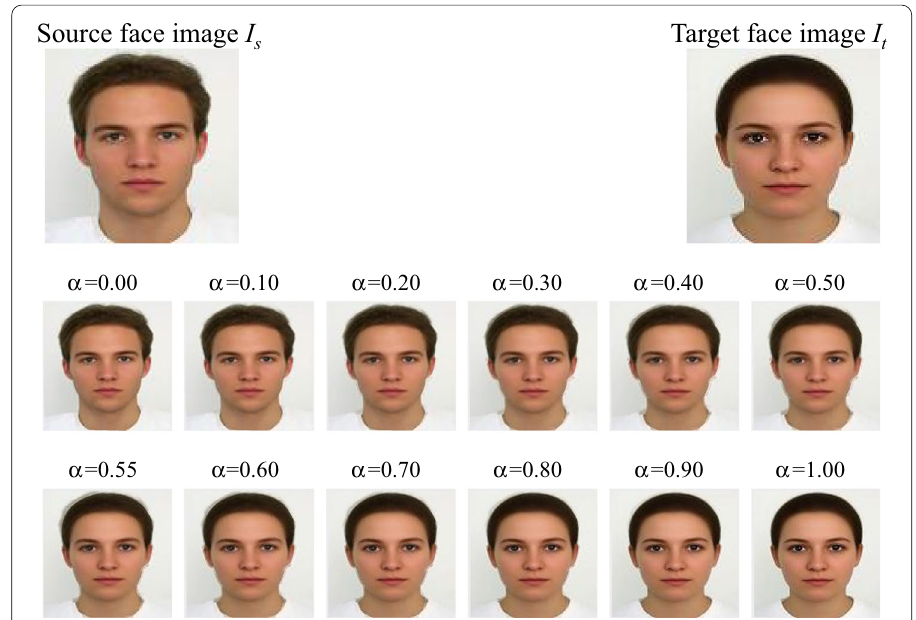
Fig. 6 A set of example images of morphed images under various α